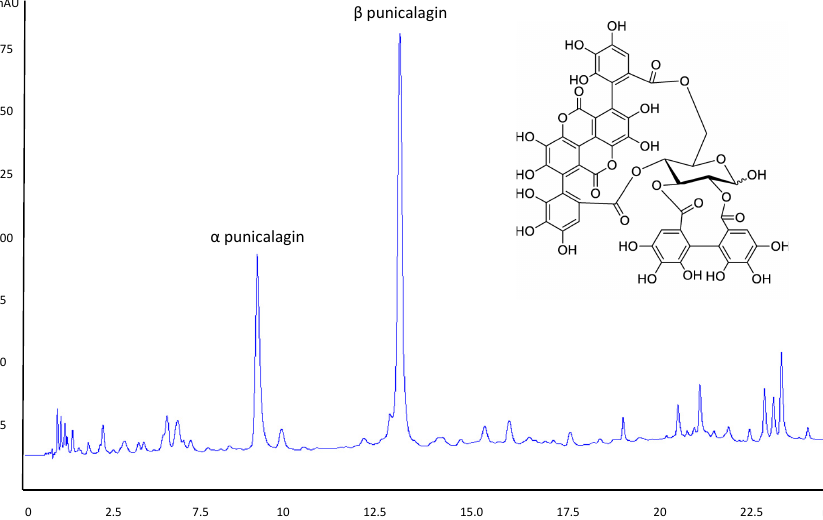
Figure 1. HPLC chromatogram showing PRE elution and highlighting the peaks due to the major ellagitannin punicalagin ( α and β anomers), which showed characteristic 1:2 α / β ratio; inset: chemical structure of punicalagin. The level of punicalagin, which is known to be the main active component, was 21.7% (or 1 mg punicalagin contained within 4.61 mg of PRE). NB α and β punicalagin spontaneously exist in this ratio. The full spectrum of components of PRE is described elsewhere.